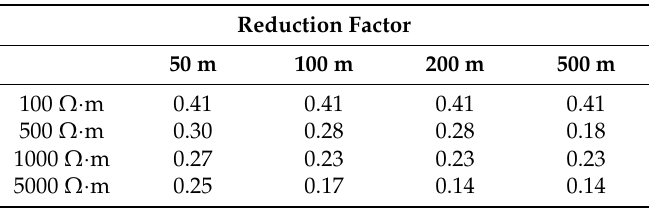
Table 8. Reduction factor of the copper